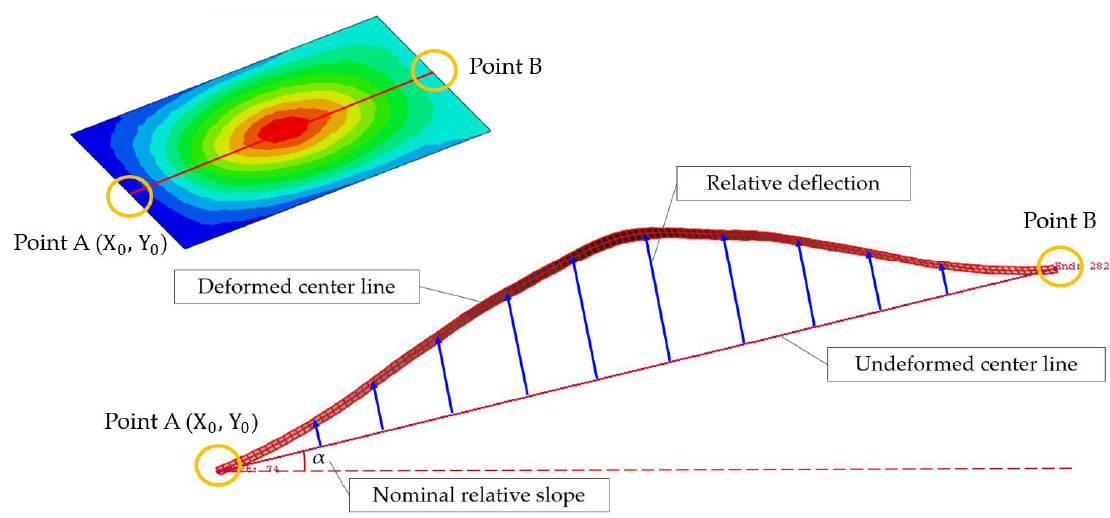
Figure 11. Calculation of relative deformation.